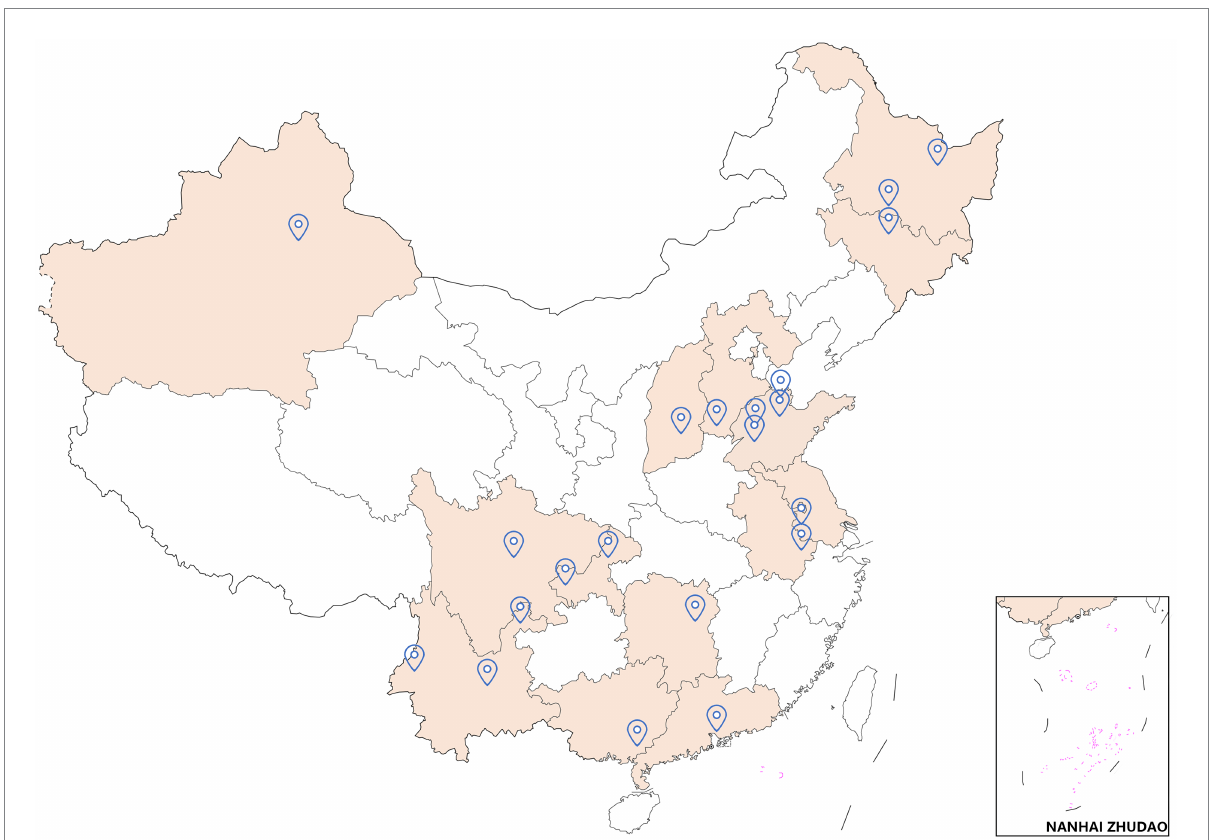
FIGURE 1 The distribution of blood centers involved in the study. 21 blood centers from 14 provinces or municipalities in China were enrolled in the present study (red colored regions and blue position marks in the map). The list of enrolled blood centers is in Supplementary Table